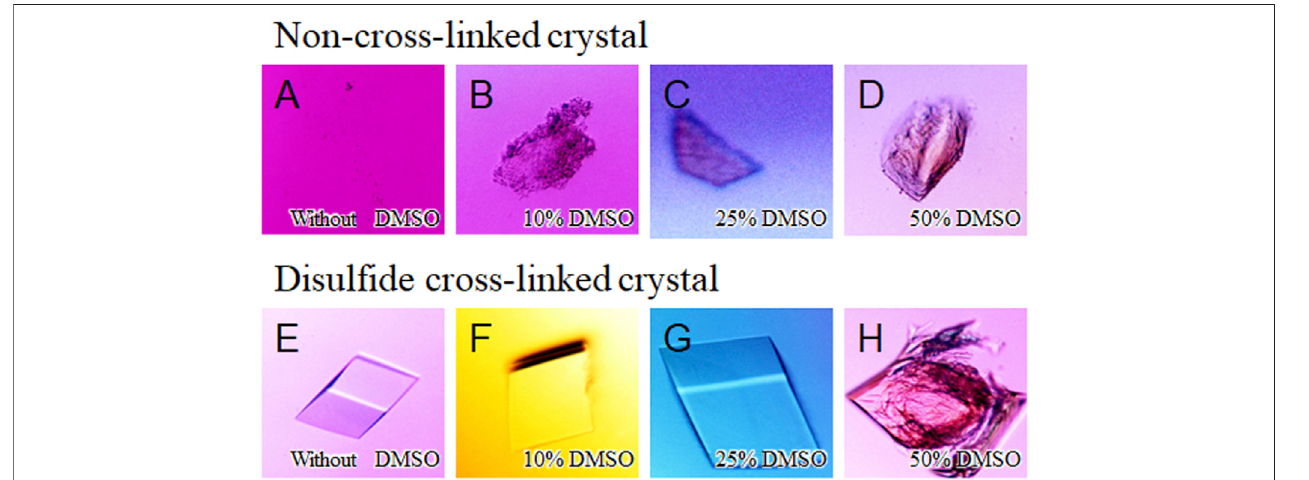
FIGURE 5 | Soaking experiment using different concentrations of DMSO solutions. Images of non-cross-linked crystals immersed in precipitant-free solutions (A) with 0% ( v / v ) DMSO, (B) with 10%, (C) with 25%, and (D) with 50% are shown. (E – H) As the same to above, images of disul fi de cross-linked crystals immersed in precipitant-free solutions with different concentrations of DMSO.